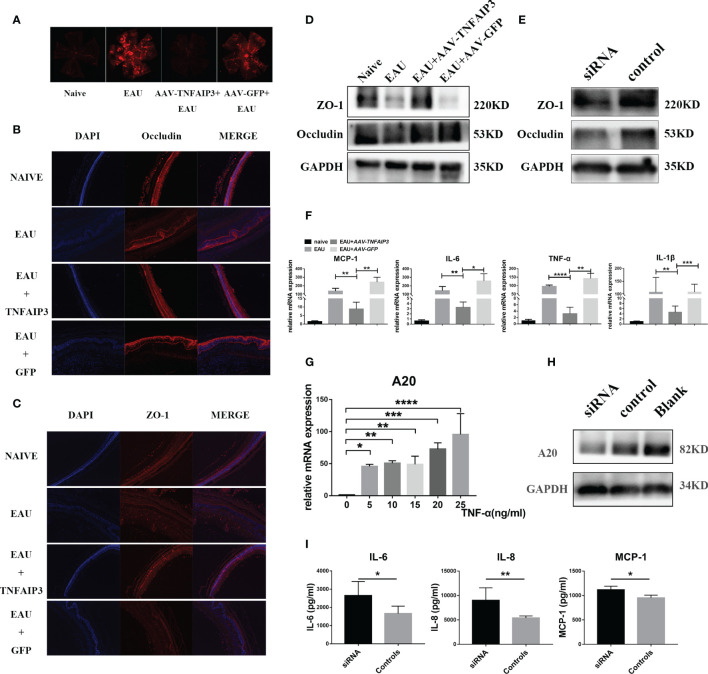
A20 overexpression 14 days prior to IRBP immunization inhibited intraocular inflammation and maintained blood-retinal-barrier (BRB) integrity and tight junction protein expression. BRB integrity of EAU mice was tested by Evans-blue. (A) Representative Evans-blue image of the retina from EAU mice in whom A20 overexpression was induced 21 days before IRBP immunization. (B) Representative immunostaining of Occludin in retinal sections of EAU mice in whom A20 overexpression was induced 21 days before IRBP immunization. (C) Representative Immunostaining of ZO-1 in retinal sections of EAU mice in whom A20 overexpression was induced 21 days before IRBP immunization. (D) Western blot tested the expression of ZO-1 and Occludin in the retinal of EAU mice in whom A20 overexpression was induced 21 days before IRBP immunization. (E) The expression of ZO-1 and Occludin was tested by Western blot. (F) Relative mRNA expression of the cytokines IL-6, MCP-1, IL-1β, and TNF-α by RT-qPCR (n≥4 per group). (G) The mRNA expression of A20 in TNF-α-induced stimulation of hRPE cells was tested by RT-qPCR (n=4 per group). (H) A20 protein inhibition in hRPE cells by A20 siRNA as tested by immunoblot. (I) The expression of IL-6, IL-8, and MCP-1 in culture supernatants was measured by ELISA (n=6 per group). Scale bar = 50 μm. Data are shown as mean ± SD. One-way ANOVA and student’s t test was used, ns p>0.05, *p<0.05, **p<0.01, ***p<0.001, ****p<0.0001.